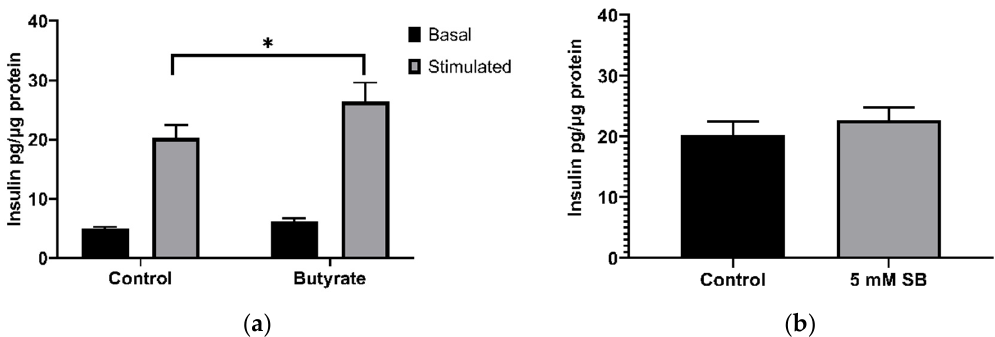
Figure 3. Acute effects of sodium butyrate on insulin secretion in BRIN-BD11 cells. ( a ) Acute effects of 20 min exposure to 5 mM sodium butyrate with (stimulated) or without (basal) 10 mM alanine and 16.7 mM glucose; ( b ) effect of 40 min treatment with 5 mM sodium butyrate followed by 20 min stimulation with 10 mM alanine and 16.7 mM glucose. Results represent the mean combined from three independent experiments, with error bars representing SEMs. * p < 0.05.